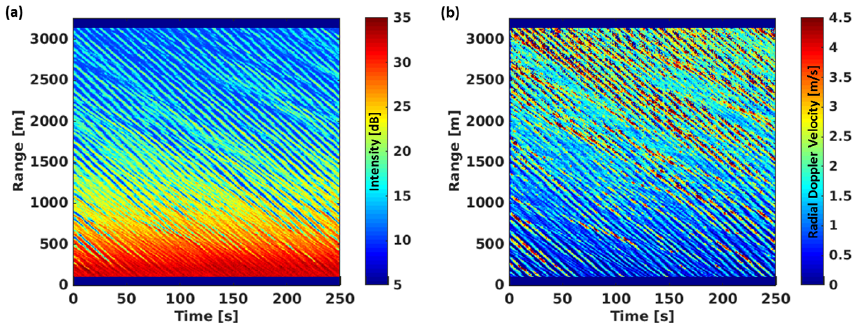
Figure 4. Time-range plot showing radar data acquired in the static mode at Fino-3 on 6 May 2015 at 23:44UTC. Radar backscatter intensity (a) and radar-retrieved radial Doppler velocity (b)